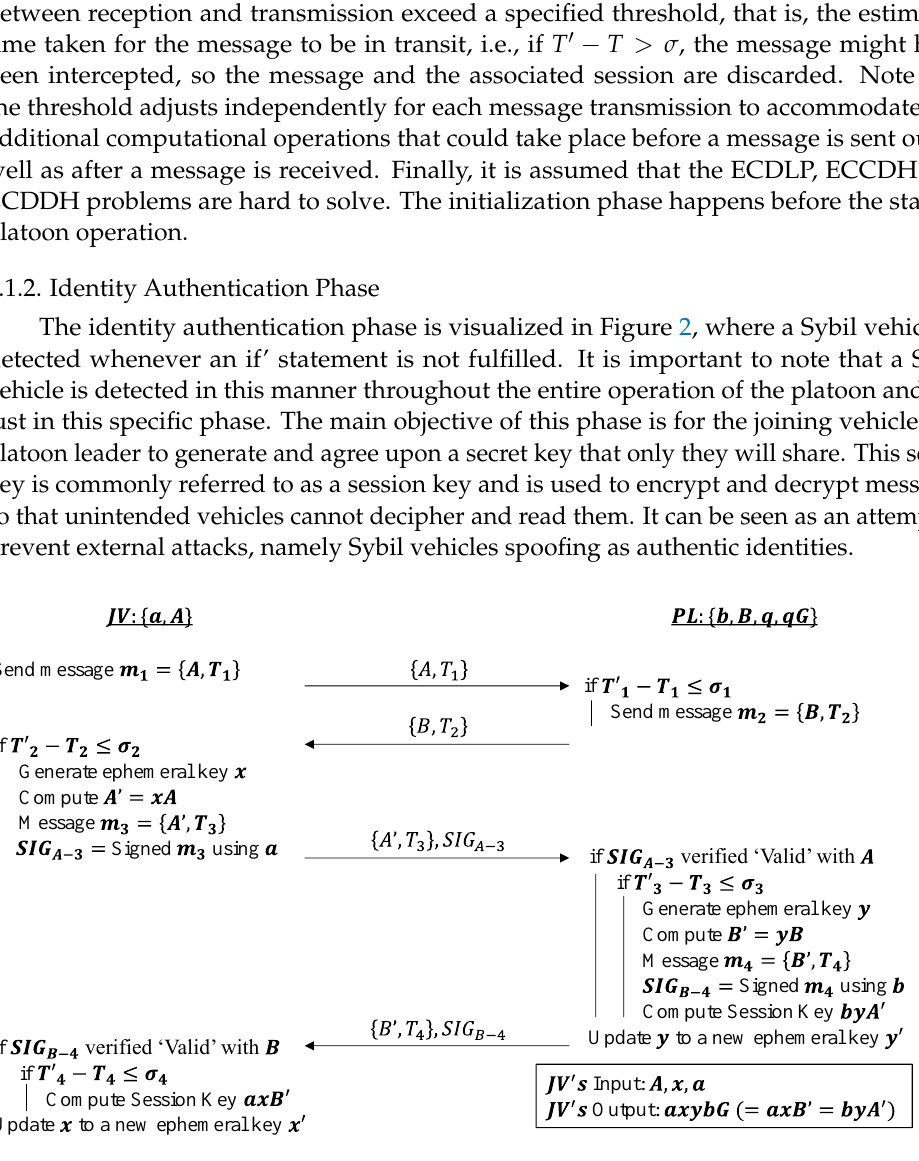
Figure 2. Identity Authentication Phase of the SPMSA.